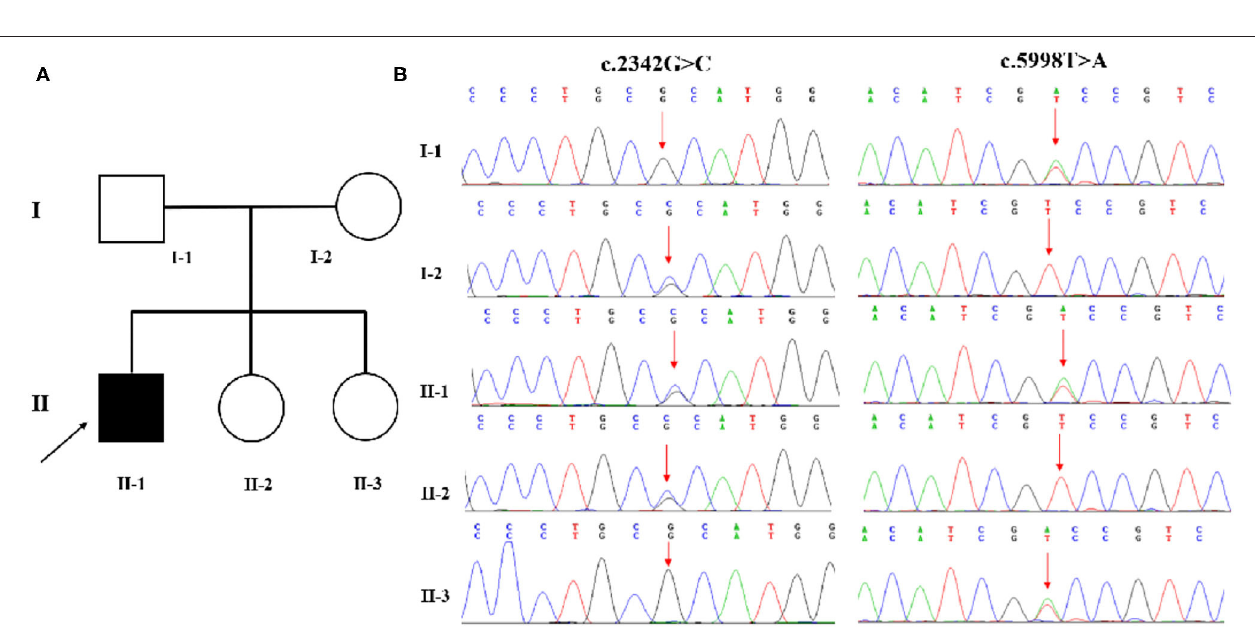
FIGURE 2 | (A,B) WES identified two variations in CAD. A missense (c.2342G>C: p.R781P) variant was inherited from the proband’s mother, and the other (c.5998T>A: p.S2000T) variant came from his father. EEG, brain MRI, and blood routine examinations are the Previous research found that an abnormal background rhythm auxiliary examinations of the essence of EIEE-50. They have with epileptic-like discharge was a common feature of EEG some regularity, but they are far from enough to locate EIEE-50. (3, 10). In our case, the situation was the same. Our